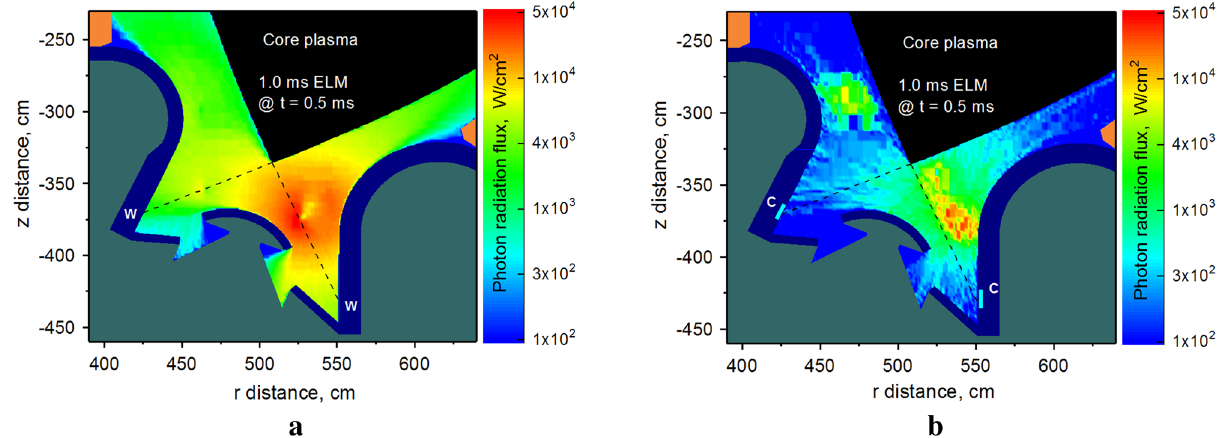
Figure 6. Snapshot of calculated photon radiation fluxes of secondary plasma at t = 0.5 ms during 1.0 ms ELM: tungsten SP ( a ), carbon insert at SP ( b ). The images were prepared using OriginPro V2020.